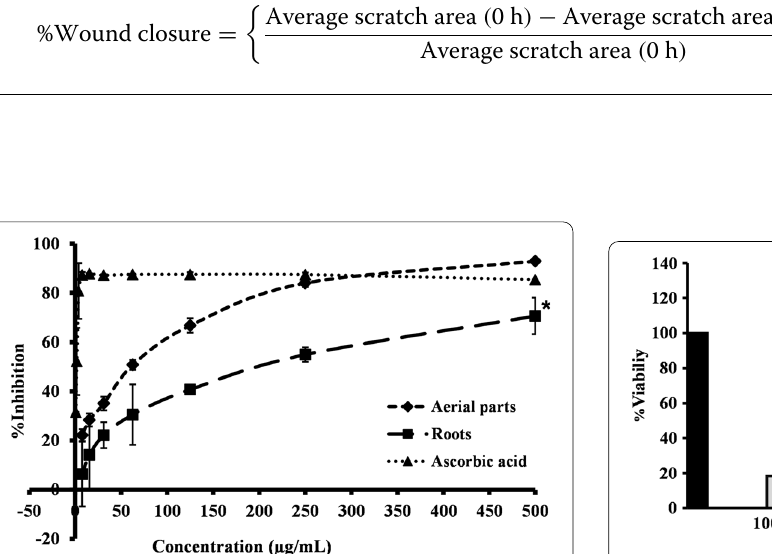
Fig. 1 Scavenging effect of DPPH. Values are expressed as mean DPPH inhibition% SD ( n 3). Statistical analysis was carried out ± = using one-way ANOVA followed by t test. *Statistically significant between arial parts/root extracts in each concentration vs. ascorbic acid at * p < 0.05